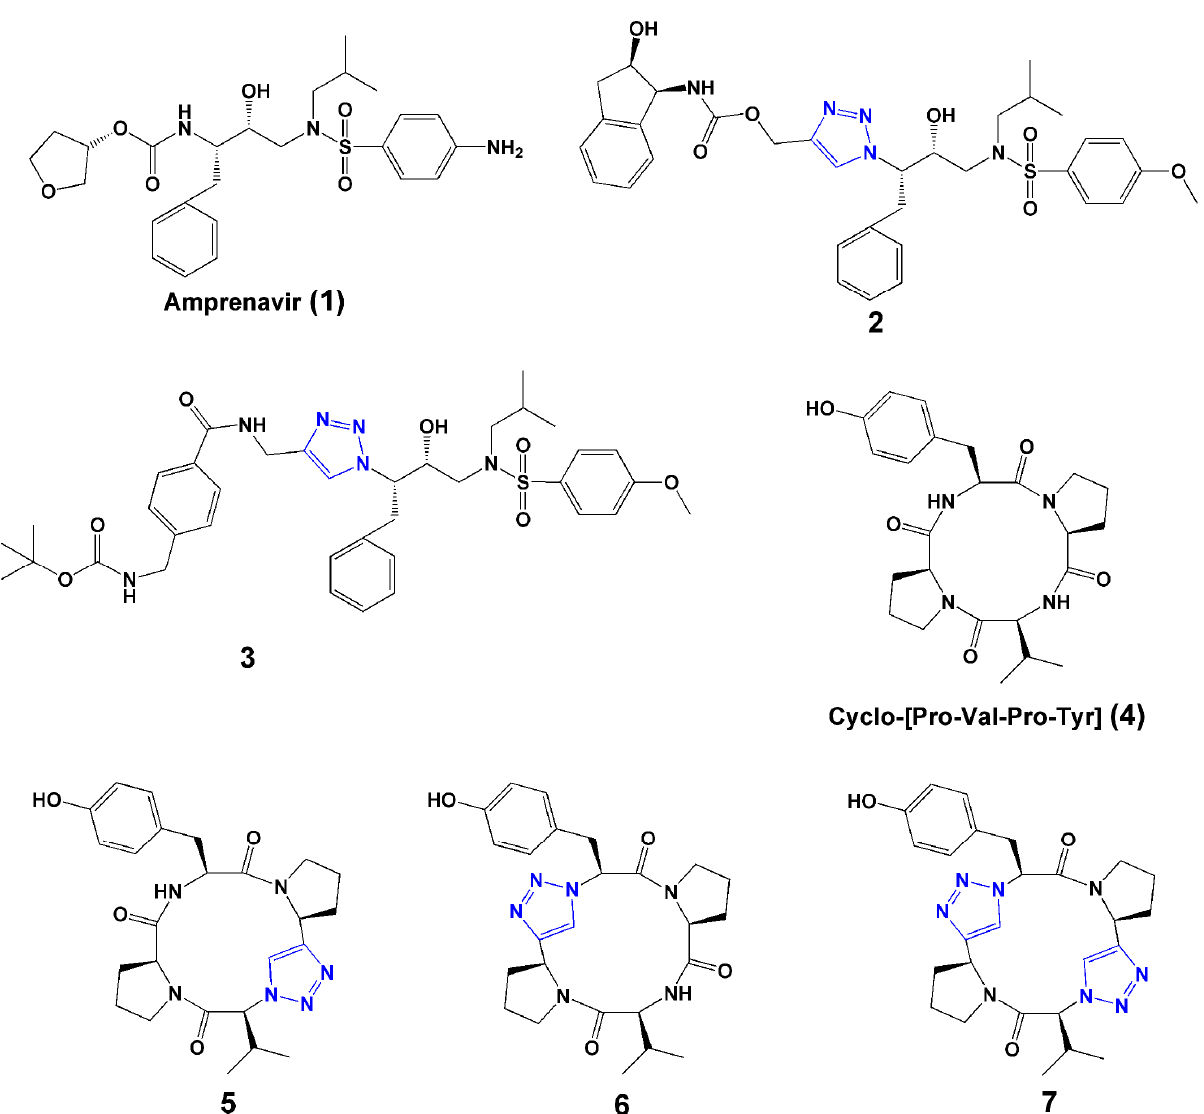
Figure 2. Selected examples of 1,2,3-triazoles used as surrogates of the amide